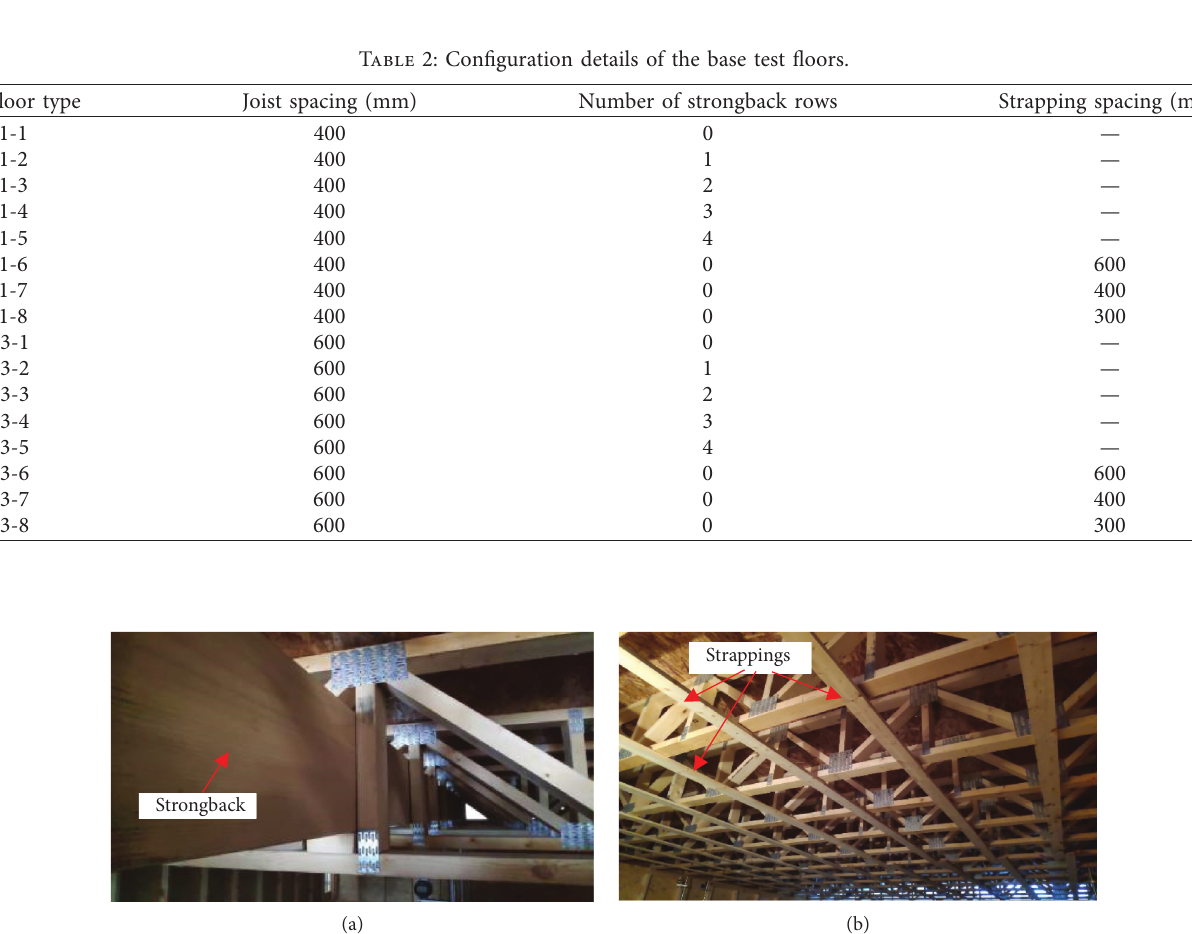
Figure 3: Installation of the bracing elements of strongbacks and strappings onto the test floors. (a) Strongbacks. (b)